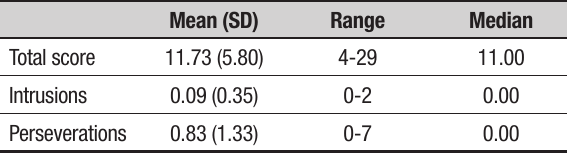
Table 3. Distribution of Verb Fluency results (total score and errors) in the total sample of Brazilian elderly people.